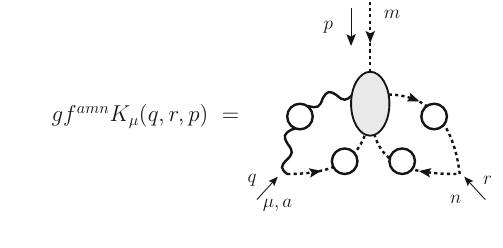
Fig. 3 The auxiliary functions appearing in the ghost-gluon vertex